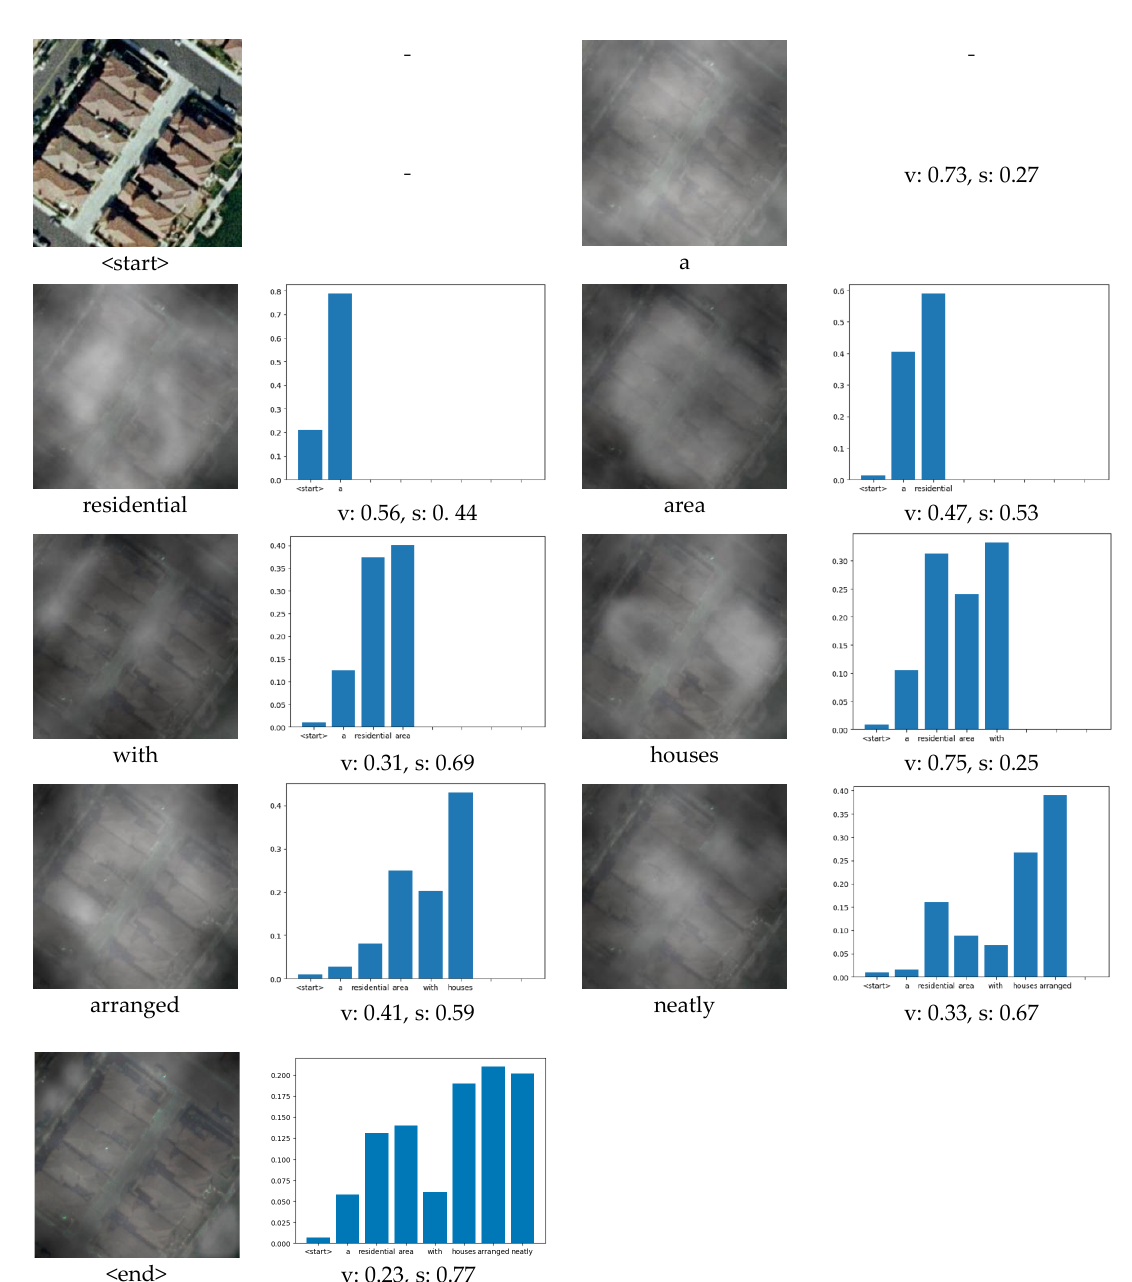
Figure 11. Visualization of our multi-level attention structures when generating the description: "a residential area with houses arranged neatly". The figure above each word indicates attention to the image, which is the visualization of the attention1 structure. And the brighter the area on the figure, the greater the attention to that area. The blue bar graph indicates attention to the past words when generating the current word, which is the visualization of the attention2 structure. "v" means "visual", and "s" means "semantic". "v: 0.23, s: 0.77" means that 23% of attention is visual and 77% of